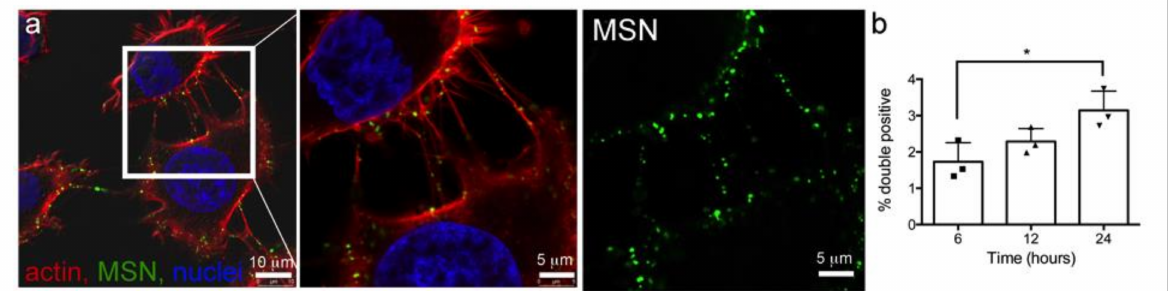
Figure 4. Cell-to-cell trafficking of MSN-laden endosomes via cellular bridges. ( a ) HeLa cells were incubated with DyLight 594-conjugated MSN (green) for 10 min, followed by fixation and labeling with AF647 phalloidin (red; actin) and DAPI (blue; nuclei). Merged and single fluorophore (gamma- adjusted) micrographs showing MSN in cellular bridges. ( b ) Flow cytometry analysis of double fluorescent HeLa cells 6–24 h after mixing two HeLa cell populations containing distinct single positive MSN. * p <